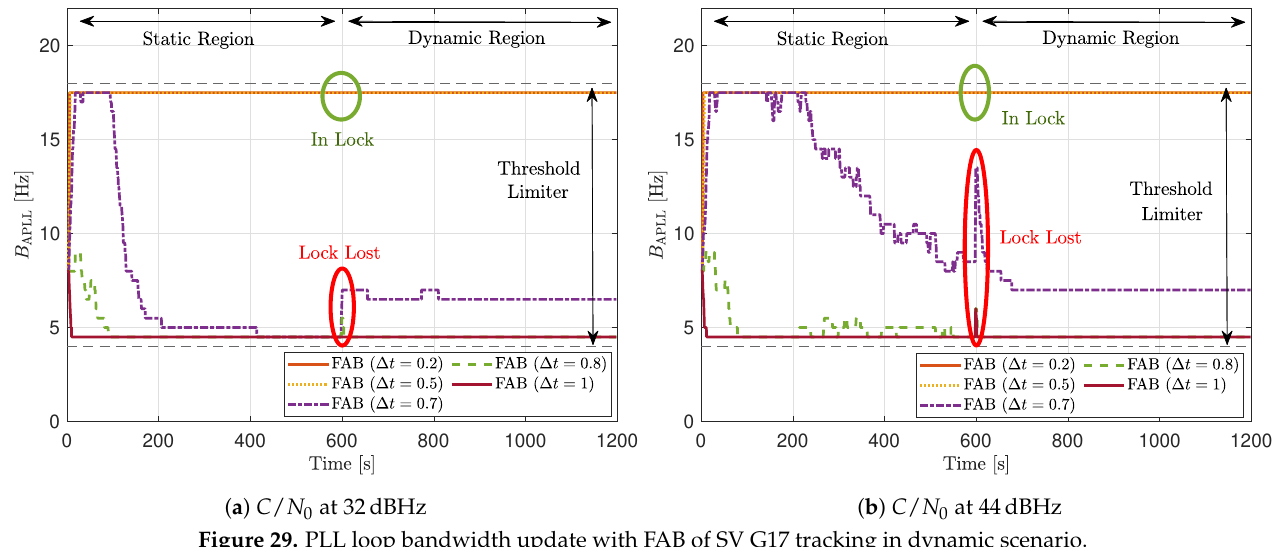
Figure 29. PLL loop bandwidth update with FAB of SV G17 tracking in dynamic scenario. Figure 30 shows the dynamic performance of the FL technique. A lower T ˜ D presents better tracking and system performance. Figure 30a shows that a T ˜ D to 0.1 achieves the lock of SV 17 down to 40 dBHz, whereas T ˜ D lock at any C / N 0 level. Regarding the system performance, any configuration of the FL technique does not achieve a PVT solution up to 36 dBHz (see Figure 30b).